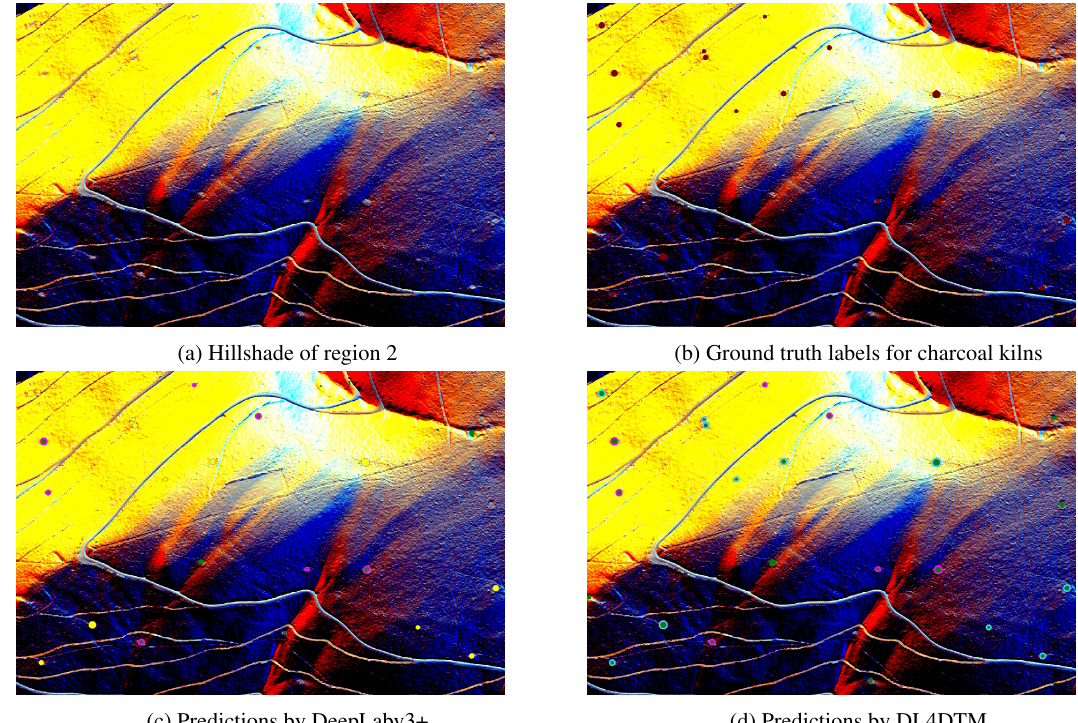
Figure 4. Region 2 containing charcoal kilns. In 4c and 4d, green indicate correct predictions, the cyan circle indicate that the model made a better prediction than the other, green shapes without the magenta circle around indicate correct predictions that were not captured during manual labeling, and yellow indicate examples not detected by the